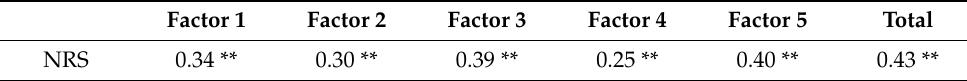
Table 3. Criterion validity of the NDEC scale.